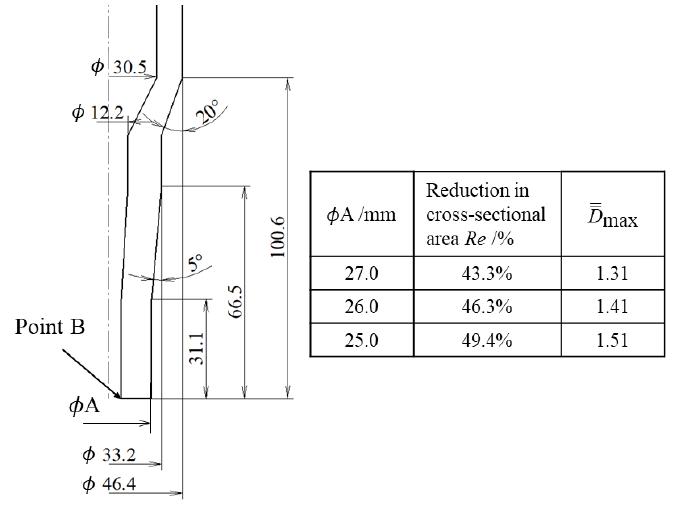
Figure 24. Reduction in cross-sectional area and calculated damage in second forward extrusion.